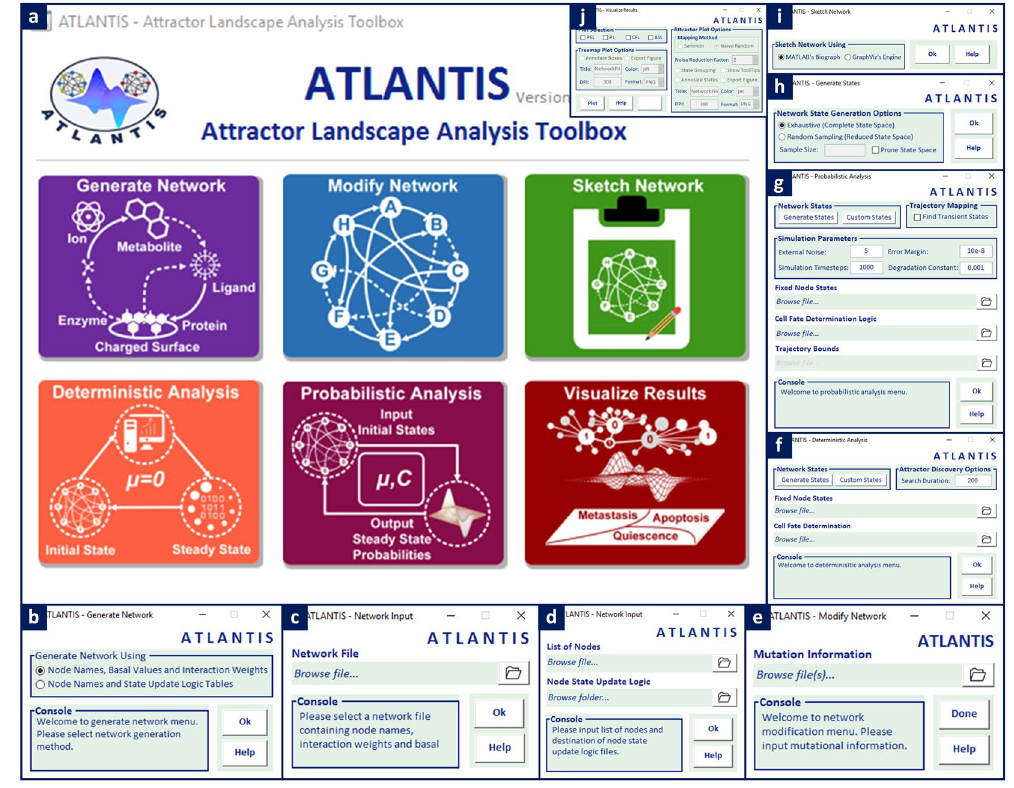
Figure 1. Graphical User Interfaces of ATLANTIS Toolbox. ( a ) Main window of the toolbox for network input, modification, analysis and visualization, ( b ) network file input dialog for loading network data from text or Microsoft Excel ® files, ( c ) interaction weights based network generation dialog, ( d ) rules-based network generation dialog, ( e ) network file modification dialog for editing node states and basal values as well as edge interaction weights, ( f ) deterministic analysis dialog, ( g ) probabilistic analysis dialog, ( h ) de novo network states generation dialog for use with deterministic and probabilistic analyses, ( i ) network sketching dialog, ( j ) visualize results dialog for plotting attractor and cell fate landscapes.